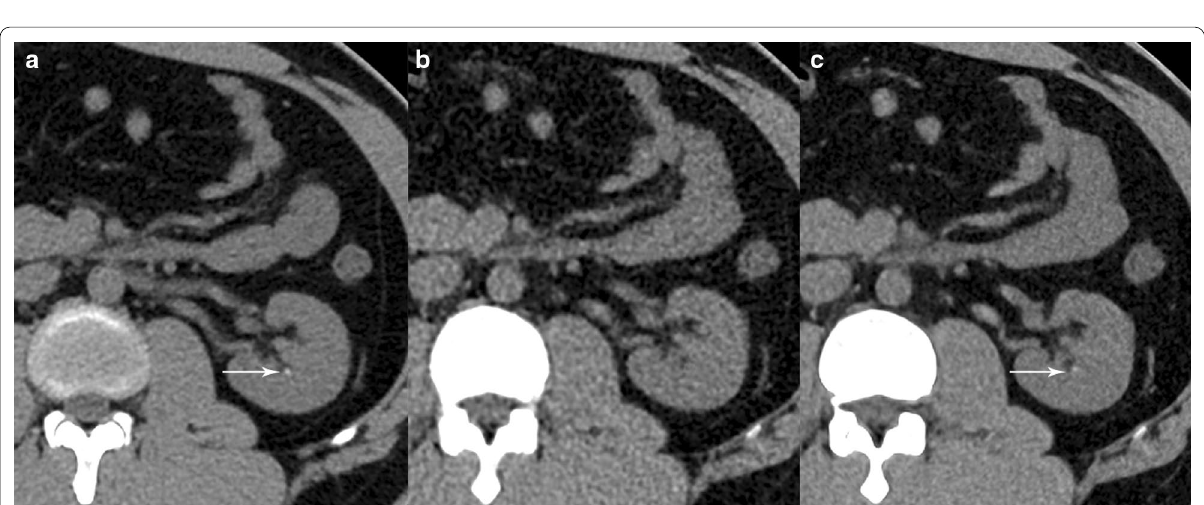
Fig. 3 CT images from a 65-year-old male patient with a clinically suspected renal calculus. A left renal calyceal calculus 1.5 mm in diameter was visible on the LD-HIR ( a ) and ULD-DLR ( c ) images but not on the ULD-HIR ( b ) image. LD-HIR means low-dose computed tomography with hybrid iterative reconstruction. ULD-HIR means ultra-low-dose computed tomography with hybrid iterative reconstruction. ULD-DLR means ultra-low-dose computed tomography with deep learning